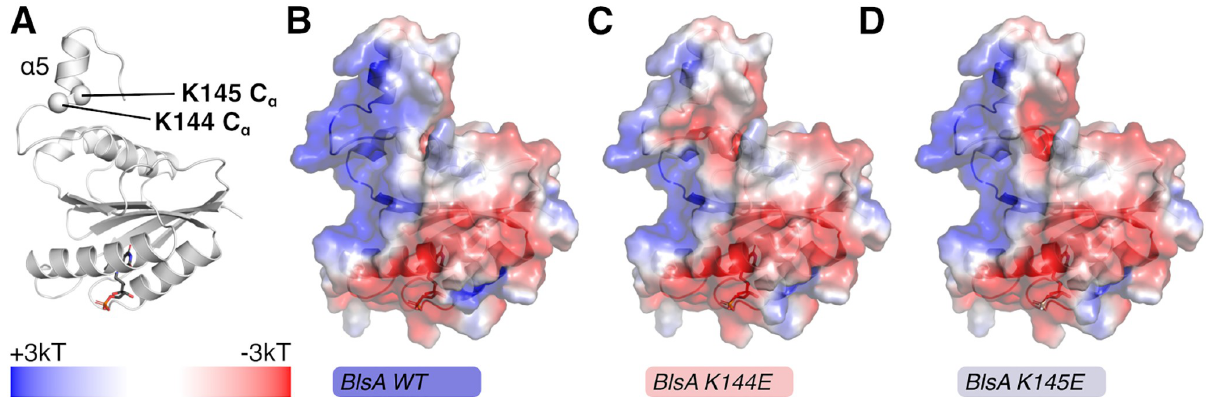
Fig 6. Effects of K144E and K145E mutations on the electrostatic surface of BlsA. (A) Cartoon model of BlsA, built using Robetta, with the positions of the α -carbons of K144 and K145 shown as spheres. The color bar indicates correspondence for the electrostatic surfaces shown in panels B-D between color and charge at ± 3kT. Panels B, C and D show the surfaces for wild type BlsA and the K144E, K145E derivatives, respectively, colored by charge on the solvent exposed surfaces as calculated with the Adaptive Poisson-Boltzmann Solver (APBS) [38, 39].